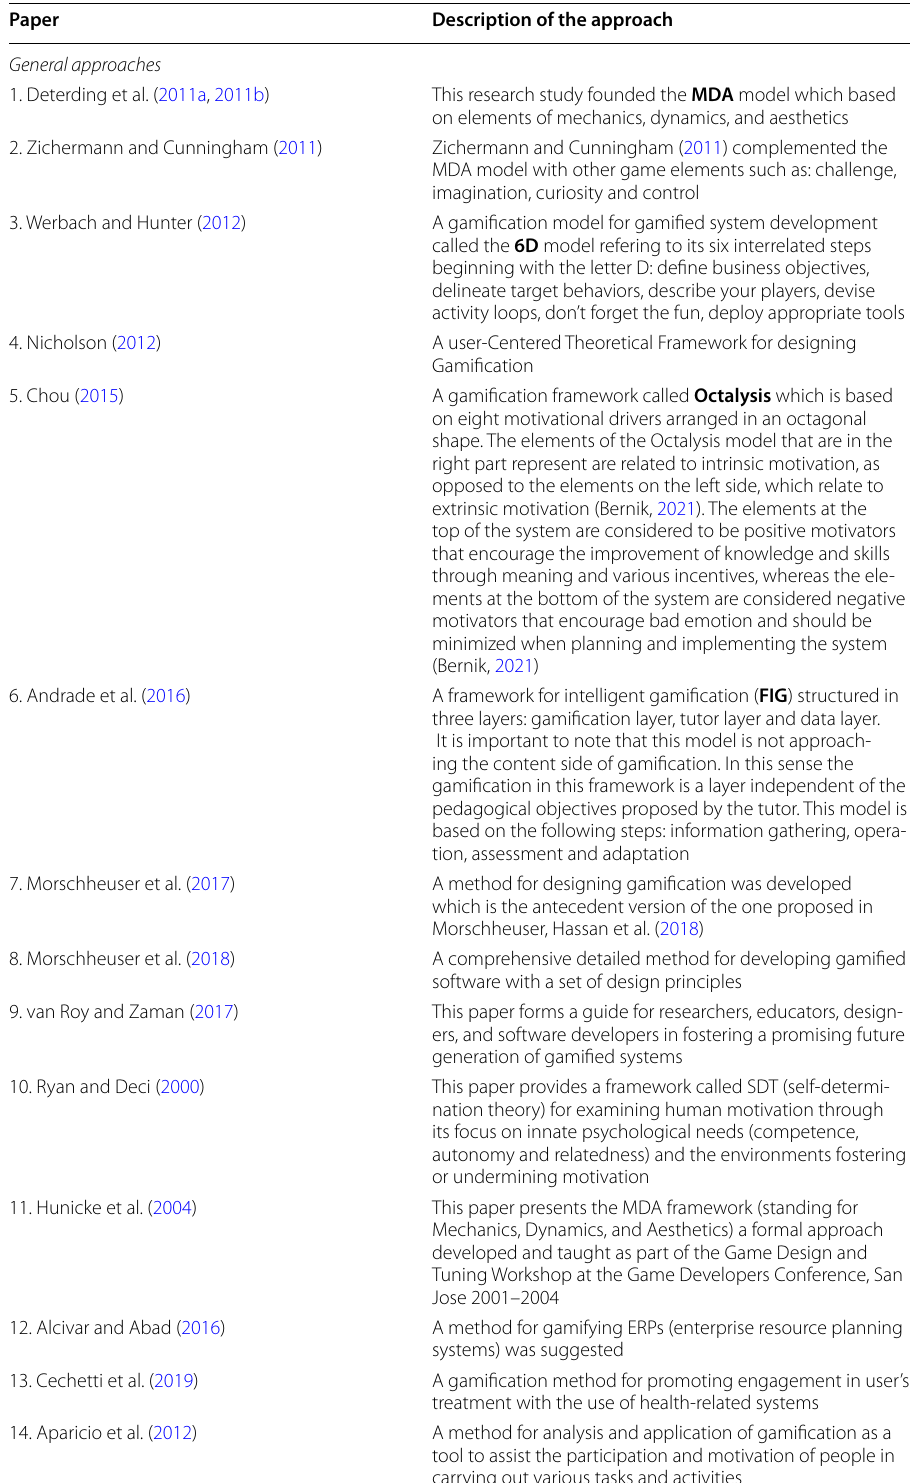
Table 3 Gamification approaches